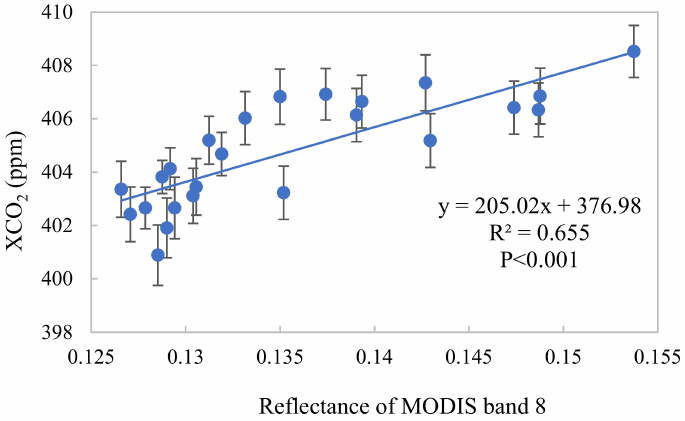
Figure 5. Scatter plots of reflectance of MODIS band 8 vs. Orbiting Carbon Observatory-2 (OCO-2) CO 2 concentration in the study